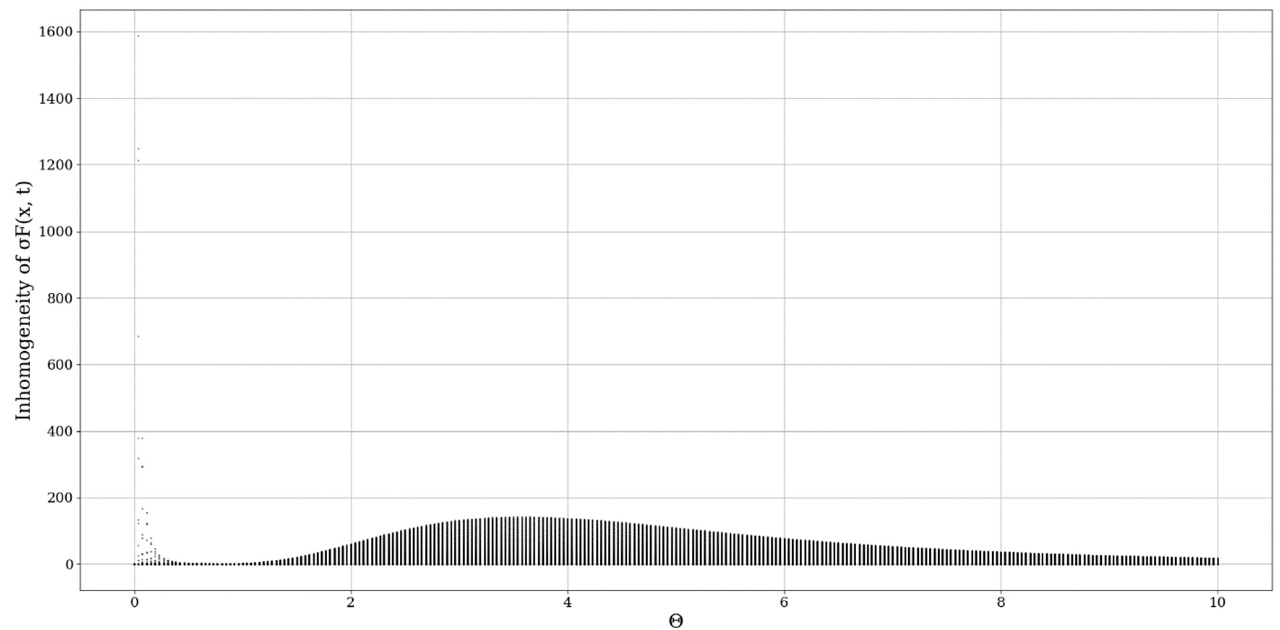
Figure 6. 〈|σ (cid:2890) (cid:3364)(cid:3364)(cid:3364)| (cid:4593)(cid:2870) 〉 example plot with θ as control parameter; ξ = 3 ; μ = 1 .